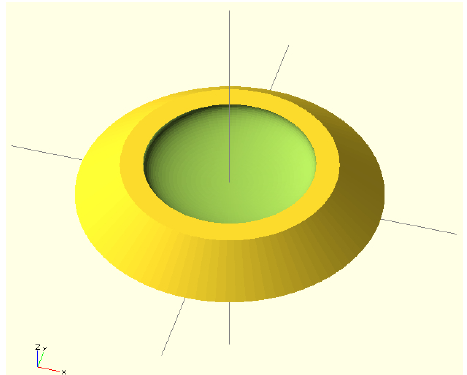
Figure 11. A customizable OpenSCAD rendering for an ant trap.